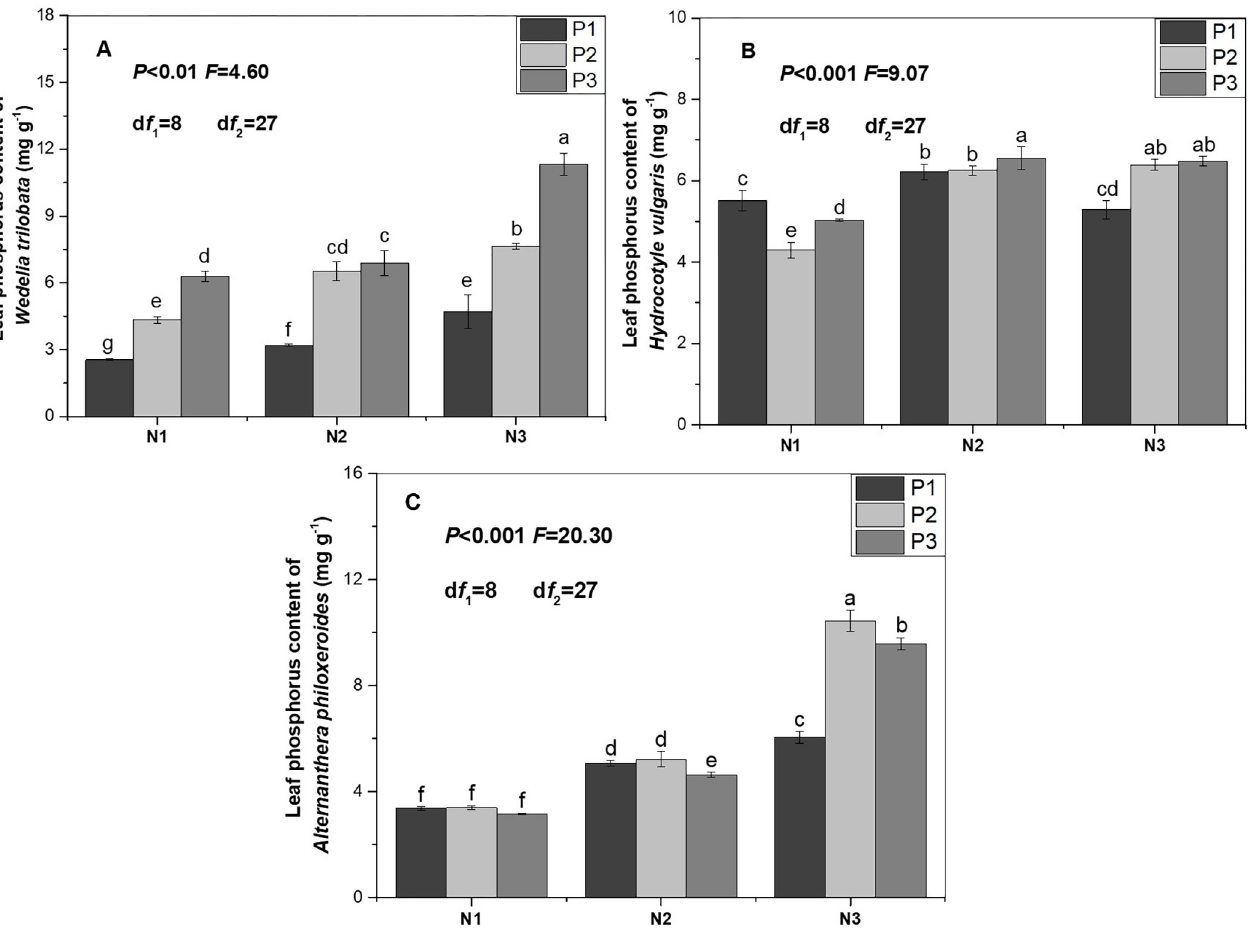
Fig 2. Phosphorus concentration in leaf of the three alien plants was subjected to different nutrient supplies. N1: Low nitrogen supply (1 mmol L -1 ); N2: Intermediate nitrogen supply (4 mmol L -1 ); N3: High nitrogen supply (8 mmol L -1 ); P1: Low phosphorus supply (0.15 mmol L -1 ); P2: Intermediate phosphorus supply (0.6 mmol L -1 ); P3: High phosphorus supply (1.2 mmol L -1 ). Values are means ± SE. Bars with different lowercase letters denote significant differences < 0.05). H (N:P) of W . trilobata and H . vulgaris was 2.78 and 6.25 respectively. The relationship between N:P ratio of leaf and N:P ratio in nutrition solution was not established in A . philoxer- oide (Table 5). N:P ratio in leaf of W . trilobata and A . philoxeroides was positively correlated with their relative growth rate (Fig 4A and 4C). However, a similar correlation was not observed in H . vulgaris (Fig 4B).